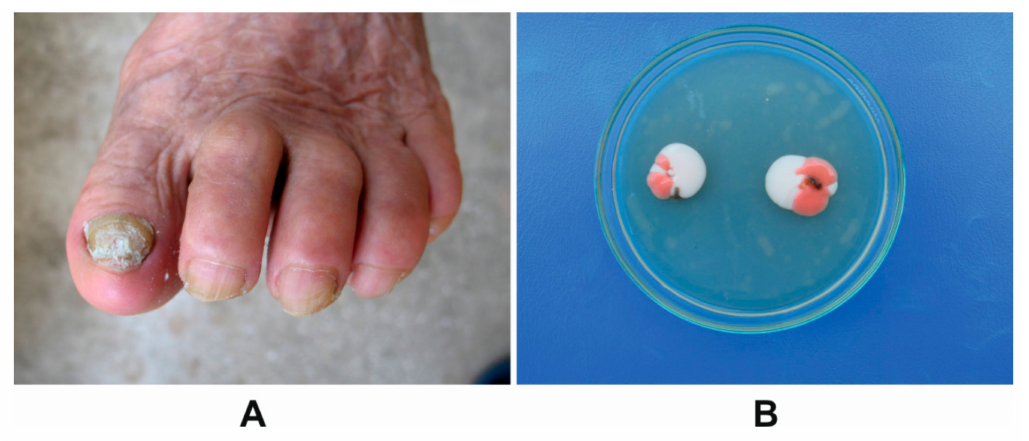
Figure 1. ( A ) Toenails a ff ected by onychomycosis; ( B ) Colonies of M. guilliermondii (white to cream) and R. mucilaginosa (in red) around a toenail fragment on SDA.